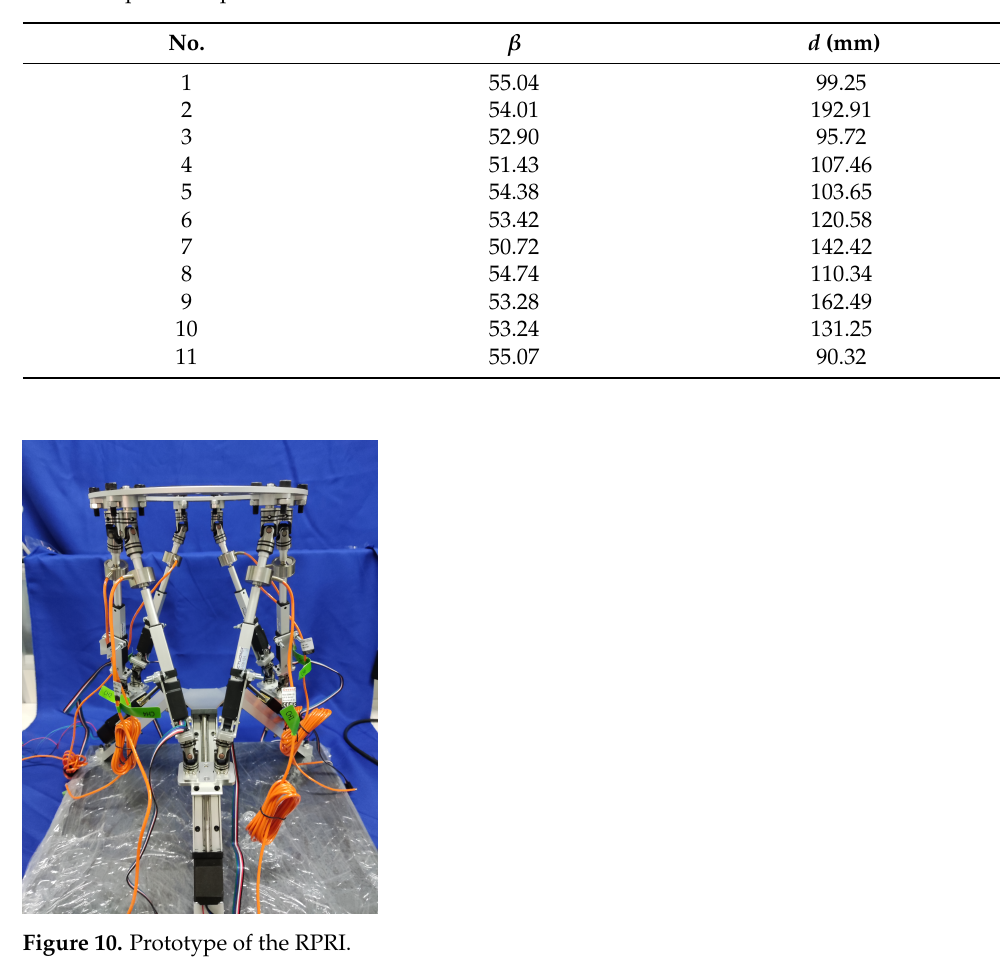
Table 5. Optimized parameters.